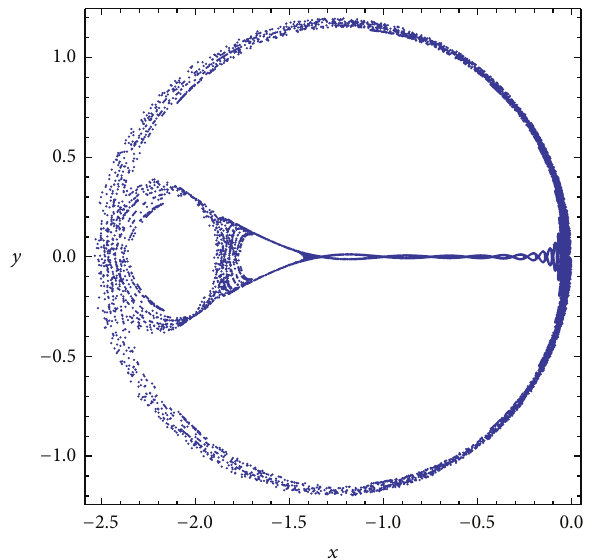
Figure 1: 𝑥 , 𝑦 plot of the Burgers